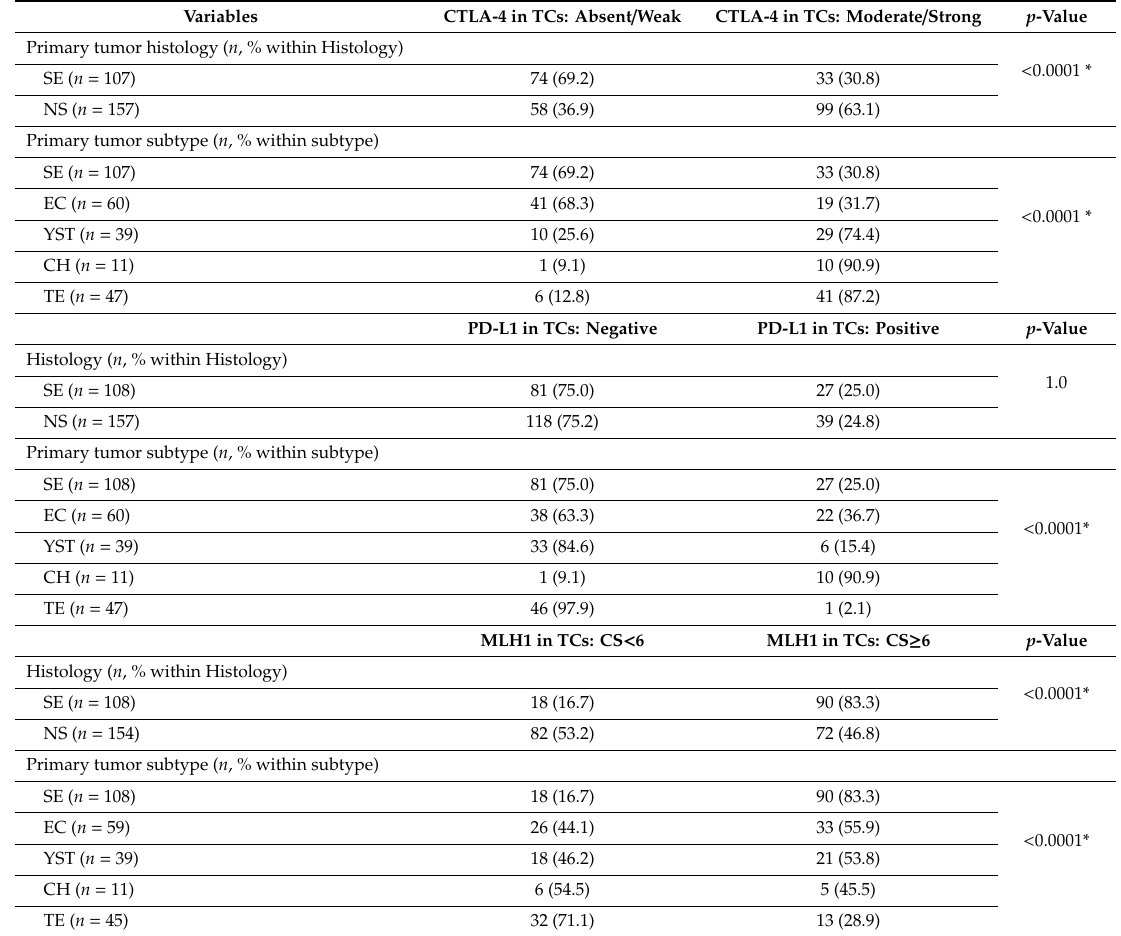
Table 5. Immunoexpression of CTLA-4, PD-L1 and MMR proteins in tumor cells of testicular germ cell